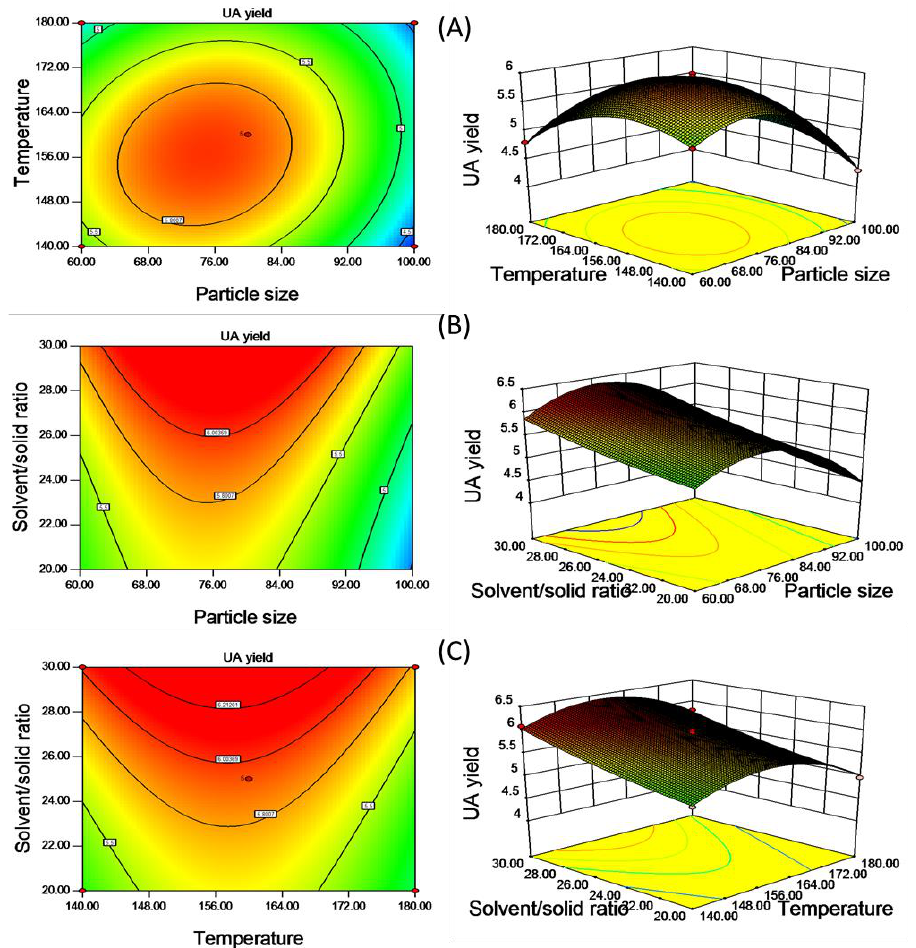
Figure 3. The 2D contour plots and the 3D response surface plots of UA yield (mg/g material) affected by the varying particle size and temperature ( A ); the varying particle size and solvent/solid ratio ( B ); the varying temperature and solvent/solid ratio ( C ).